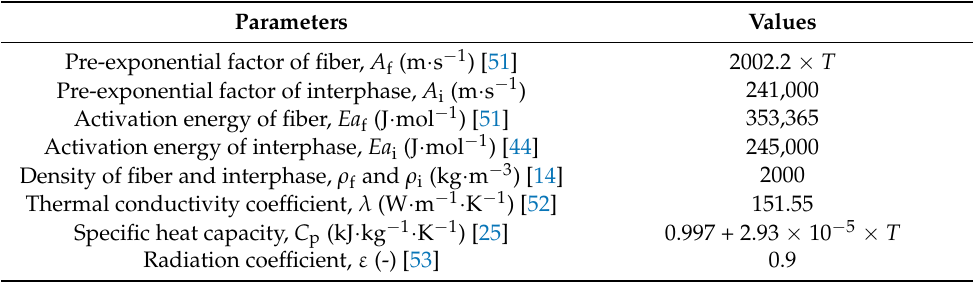
Table 1. Properties of carbon/carbon